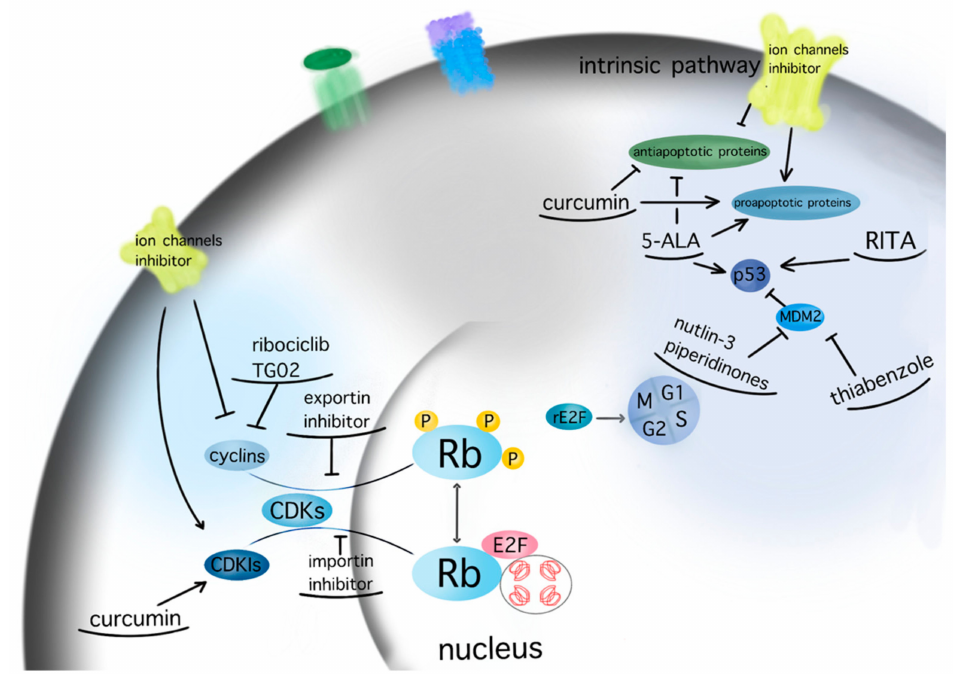
Figure 4. Molecular targeting of GBM therapeutic agents. The current figure depicts the molecular targets of potential therapeutic agents for GBM within the pathways of apoptosis and cell cycle (arrow: upregulation; line: